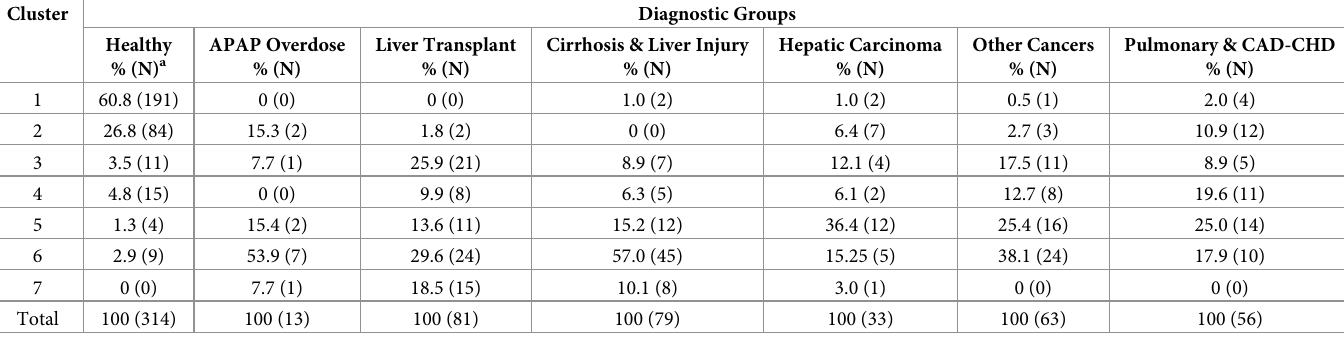
Table 3. Distribution of subjects by diagnostic groups.